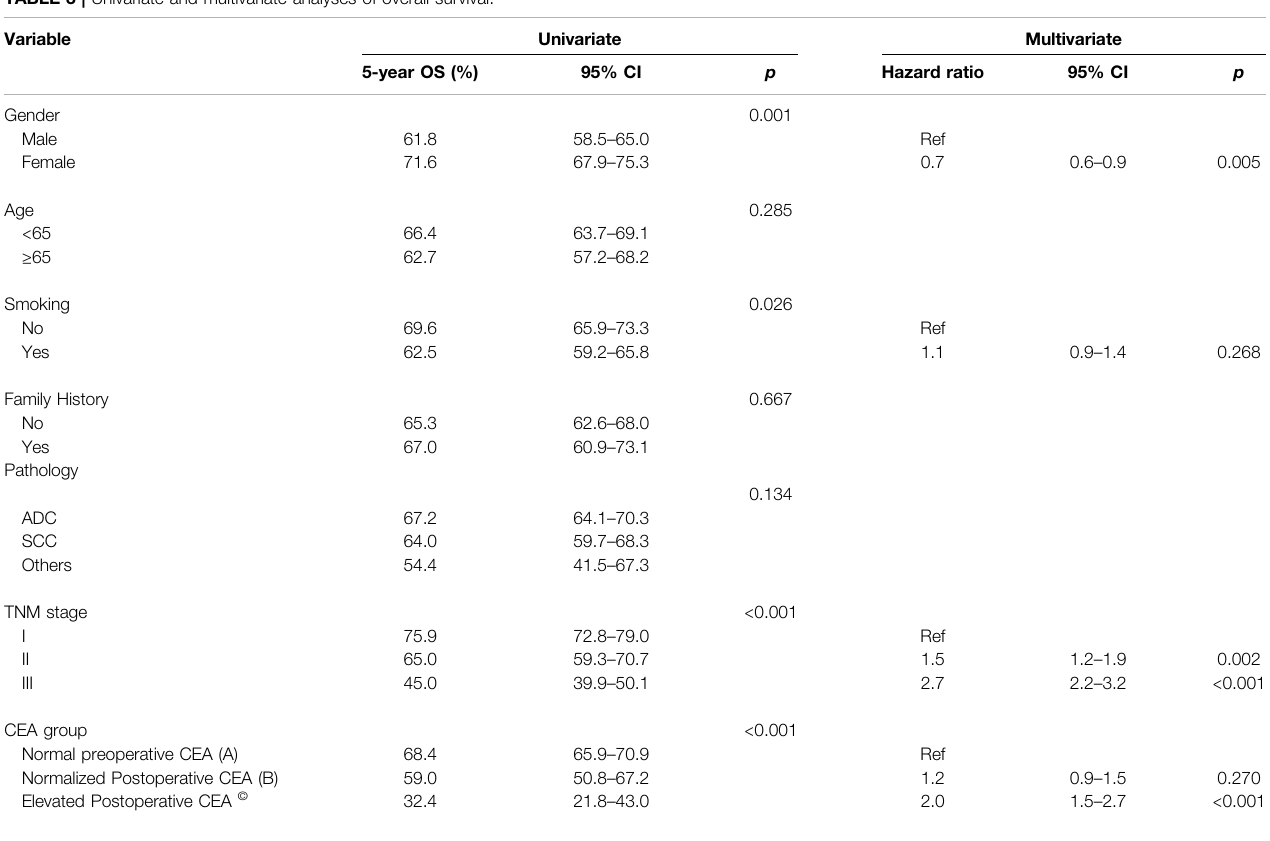
TABLE 3 | Univariate and multivariate analyses of overall